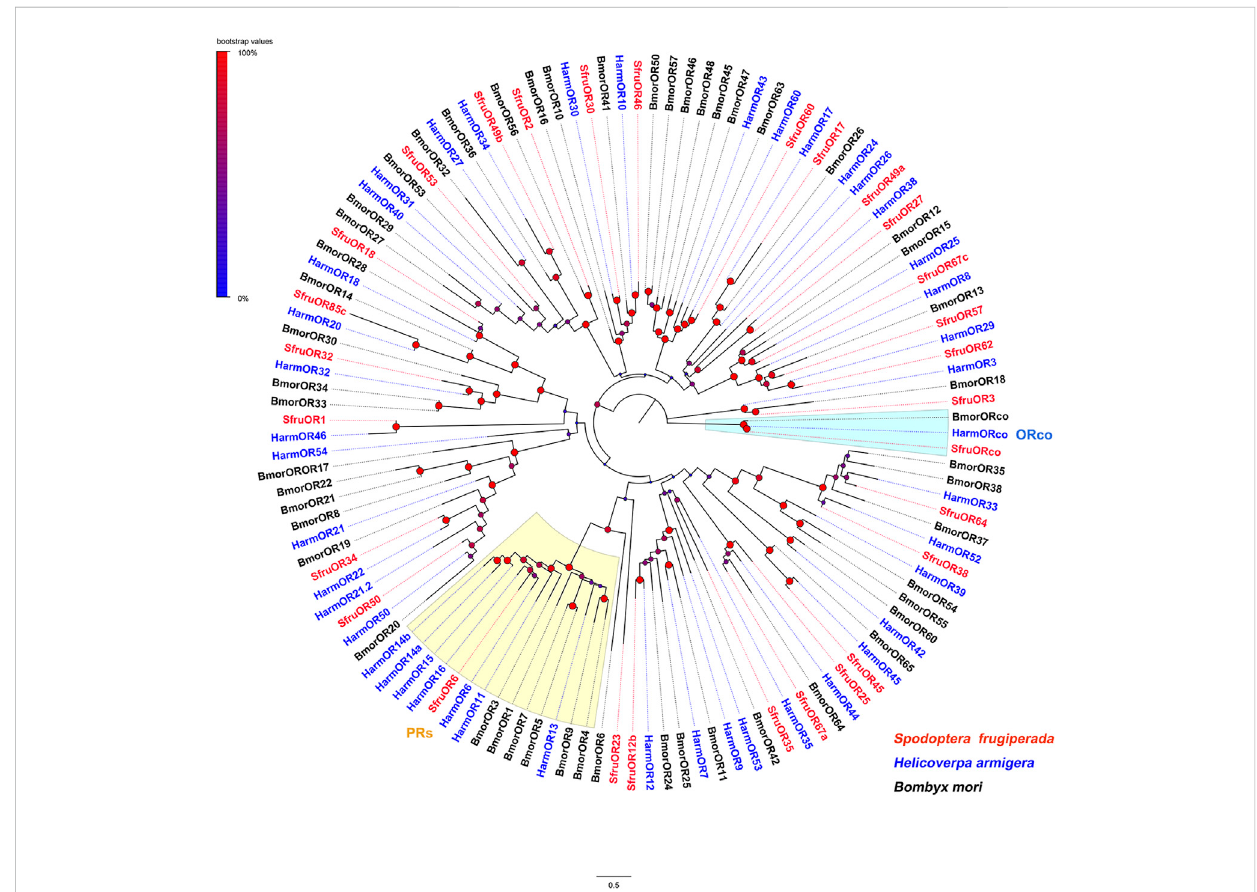
FIGURE 1 Neighbor-joining tree constructed with candidate ORs from Spodoptera frugiperda and homologs from H . armigera and B . mori . The tree was rooted by the ORco orthologs. Node support was estimated with 1000 bootstrap replicates, and bootstrap values were displayed with circles based on the scale indicated at the top left. The scale bar at the bottom indicates the branch length in proportion to amino acid substitutions per